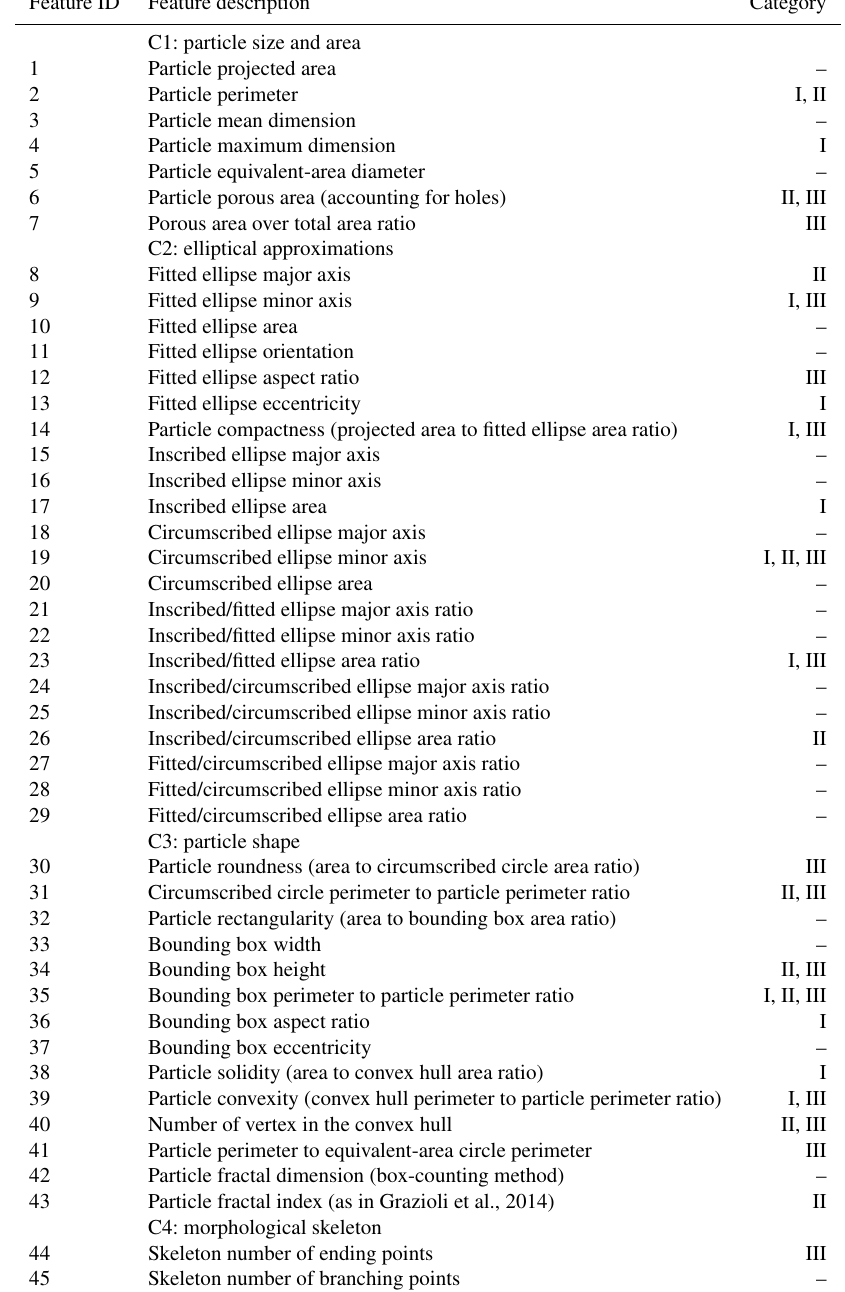
Table A1. Initial list of numerical descriptors provided to the classification model before feature selection. The seven categories correspond to the different subsections introduced in Sect. 2.3. For each line, the last column indicates whether the corresponding feature is retained for (I) hydrometeor-type classification, (II) riming degree estimation and (III) melting snow detection after the feature selection as been applied, as detailed in Sect.